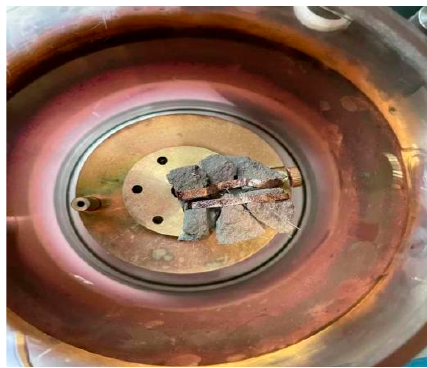
Figure 3. Gold-sprayed sample.